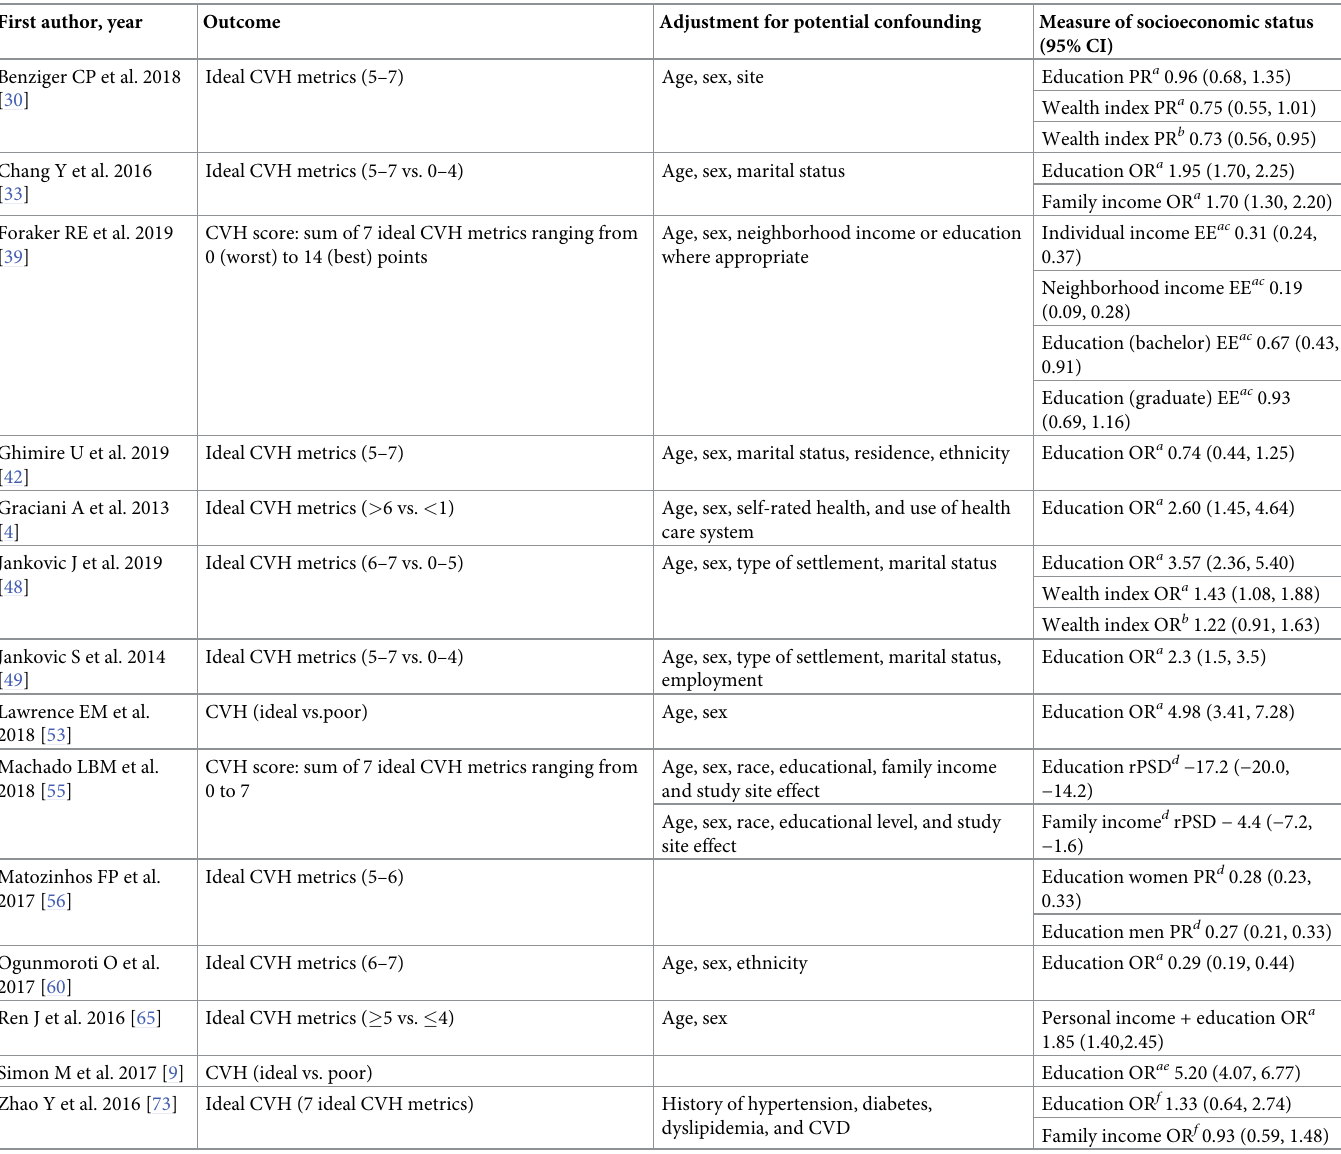
Table 3. Studies describing the association between socioeconomic variables and prevalence of ideal cardiovascular